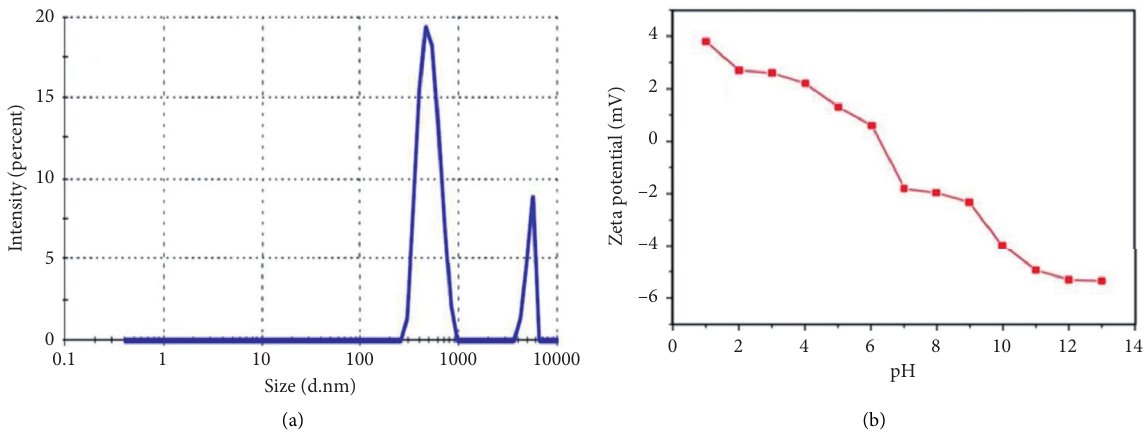
Figure 1: (a) The particle size distribution of APC after carbonization at 400 ° C for 120min. (b) Zeta Potential curve of APC.